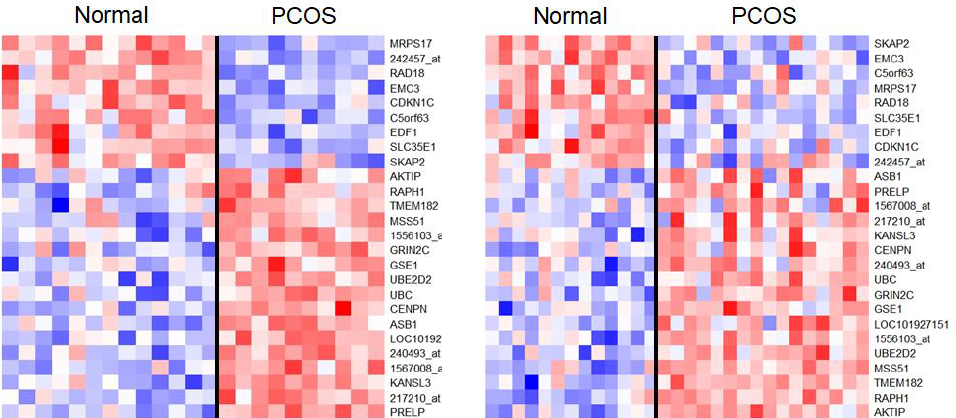
Figure 3. Heatmaps of DEGs that were found to be significant upon using the Bonferroni correction of the meta-analysis results. As in Figure 2, probe names are used for annotation in cases where no genes were mapped to the probes. The genes are ordered according to t -statistics and the gene orders are different between the datasets (left: GSE8157, right: GSE6798). Normal and PCOS groups are divided using black lines.